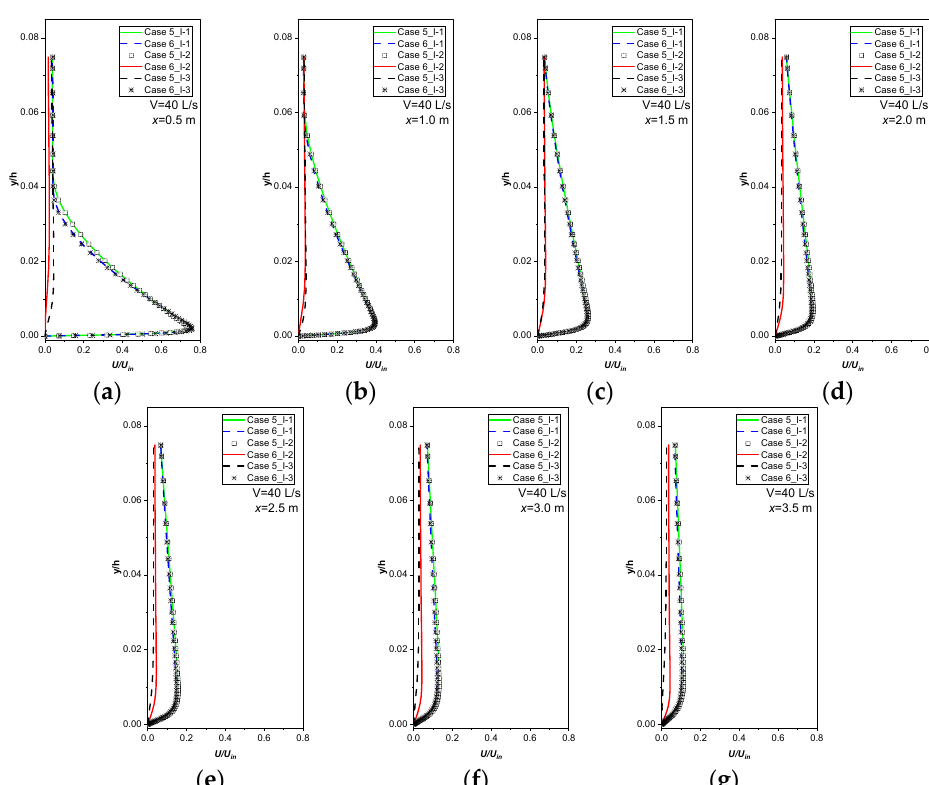
Figure 6. ( a – g ) Show the velocity change along the centerline of the floor for all evaluated cases with V = 40 L/s at x distances 0.5–3.5 m. V = 40 L/s at x distances 0.5–3.5